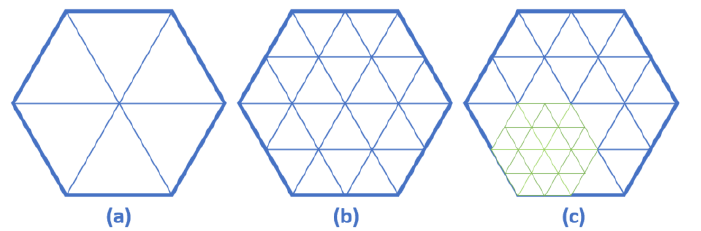
Figure 7. Adaptive sampling area division of the honeycomb structure ( D = 6). ( a ) Partition of particle initial iterative region; ( b ) 2 iterations to search the domain model; ( c ) Schematic representation of iterative derivation of the search domain.